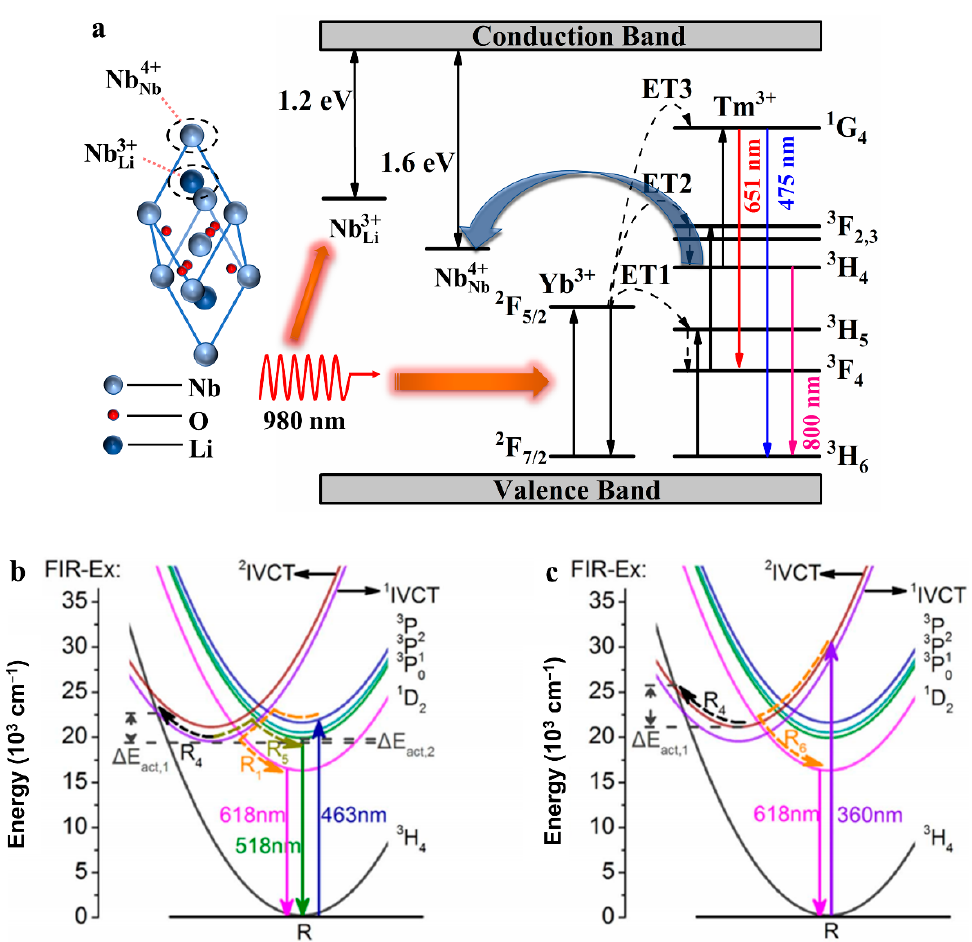
Figure 5. ( a ) The energy level diagram illustrating the luminescence mechanism in Tm 3+ , Yb 3+ : LiNbO 3 under 980 nm excitation [45]. Schematic configurational coordinate diagrams for the FIR-Ex strategy in Pr:CLN with ( b ) 463 nm excitation and ( c ) 360 nm excitation [46].